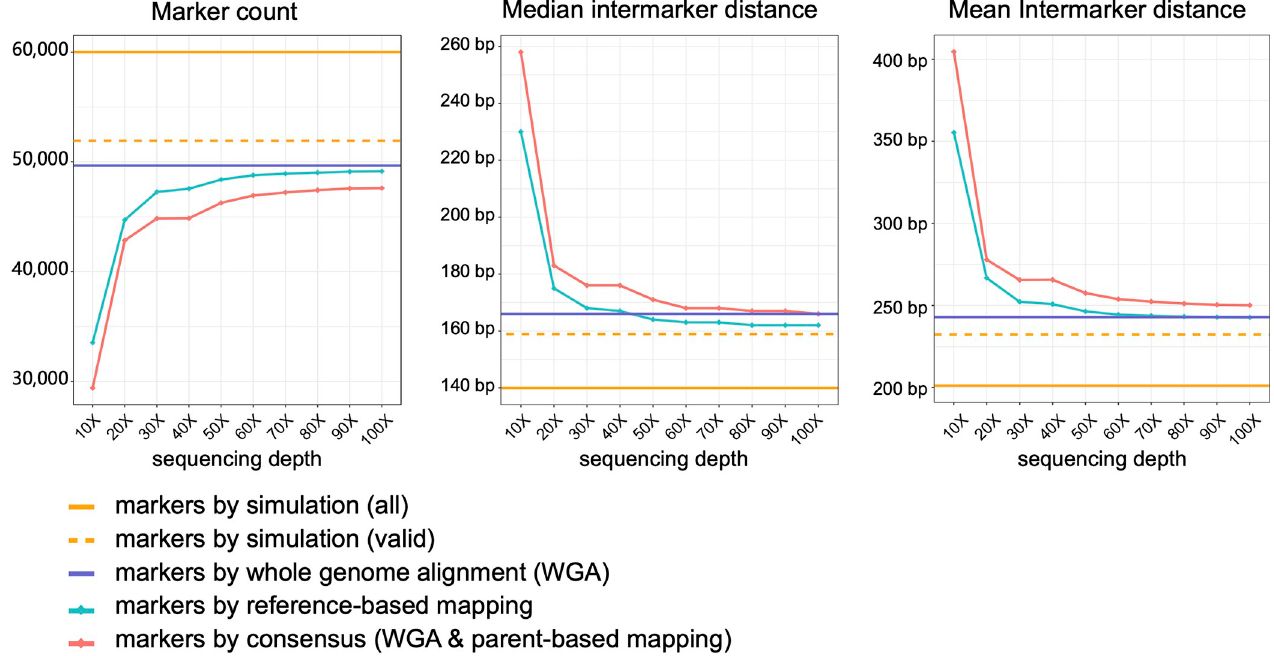
Fig 2. Performance of polymorphic marker identification with RecombineX. A total of 60,000 SNV markers (denoted as “all”; solid orange line) together with 6,000 Indels and 6 CNVs were simulated for two hypothetical parent genomes, among which 51,913 of them are considered as valid marker discovery targets (denoted as “valid”; dashed orange line) as they are not associated with repetitive regions nor CNV regions. We gauged RecombineX’s performance for marker identification based on these two hypothetical parent genomes and their reads (simulated sequencing coverage: 10X, 20X, 30X, ... , 100X) using different marker identification protocols implemented in RecombineX: reference-based mapping (solid green line), whole genome alignment (solid purple line), and consensus between whole genome alignment and parent-based read mapping (solid red line). For each case, the total marker counts as well as the median and mean inter-marker distance were plotted